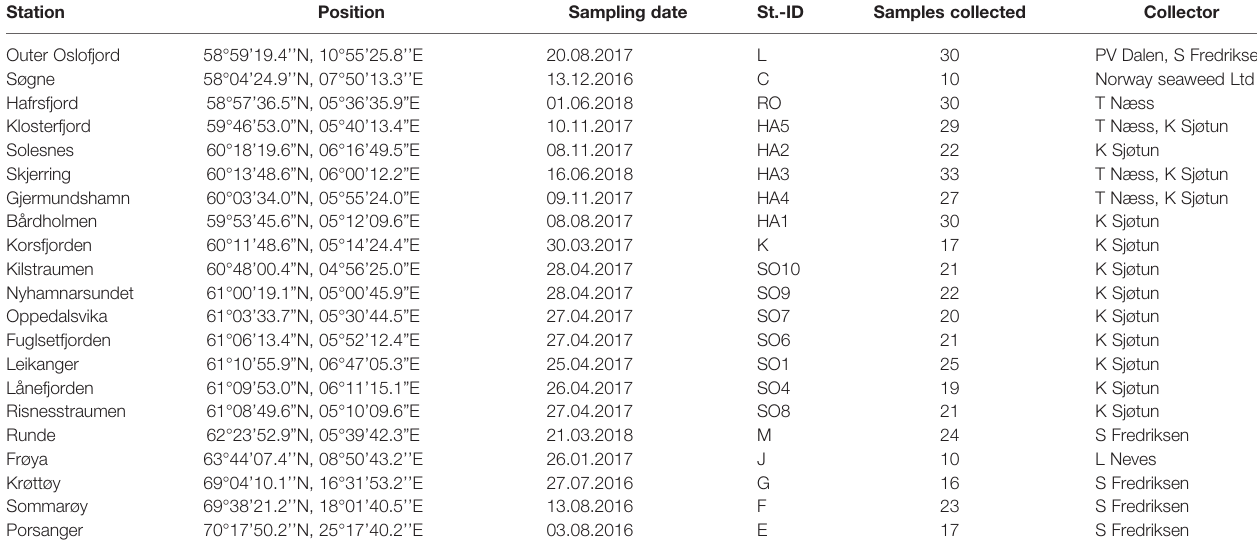
TABLE 1 | Overview of the 21 stations with name of station, position, sampling date, Station-ID, number of samples collected and name of collector.